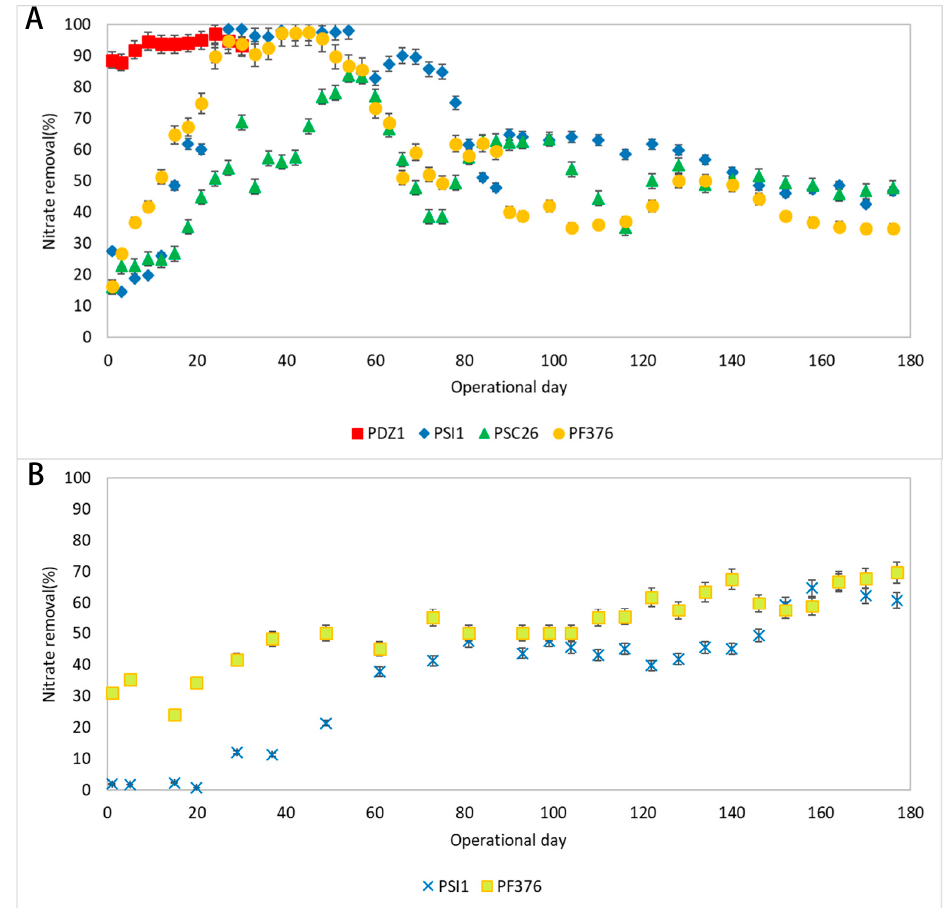
Figure 8. Nitrate removal ratio of granular biomass for Pseudomonas fluorescens PSC26 (PSC26), Pseudomonas fluorescens 376 (PF376), and Pseudomonas stutzeri I1 (PSI1) fed with sodium acetate ( A ) and methanol ( B ).